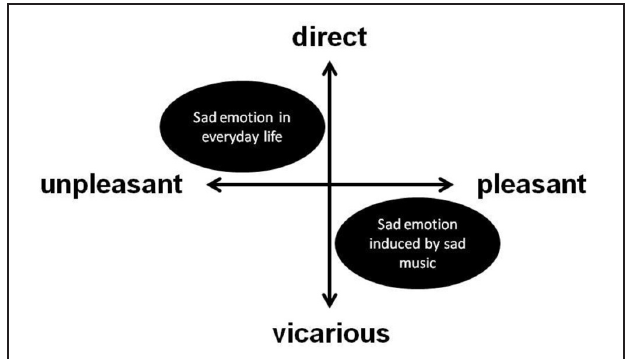
FIGURE 2 | Pleasant–unpleasant, direct–vicarious model.